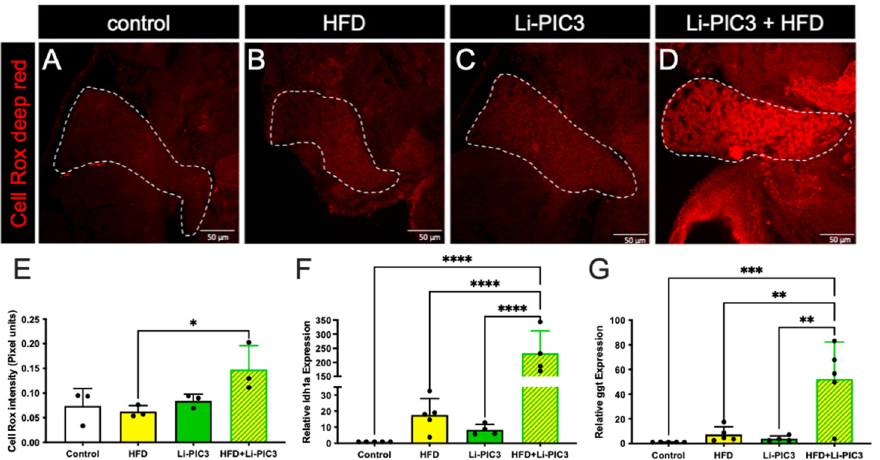
Figure 4. ROS mediated stress is induced in livers of zebrafish fed a high-fat diet and liver-specific cytokine induced embryos. ( A – D ) Cell Rox Deep Red staining used to visualize ROS-mediated stress in the livers of control, HFD-fed, Li-PIC3, and Li-PIC+HFD larvae. ( E ) Quantification of Cell Rox intensity demonstrated an increase in only Li-PIC3+HFD embryos as compared to Tg(fabp10:cre) controls, while the comparison to controls trended towards significance ( p = 0.776). ( F ) Quantification of ldh1a mRNA levels by qPCR ( G ) Quantification of ggt mRNA levels by qPCR. Both ldh1a and ggt are elevated in the combined Li-PIC3+HFD condition. Statistical analysis was by one-way ANOVA, n = 4–5 per condition; * p < 0.05, ** p < 0.01, *** p < 0.001, **** p < 0.0001.